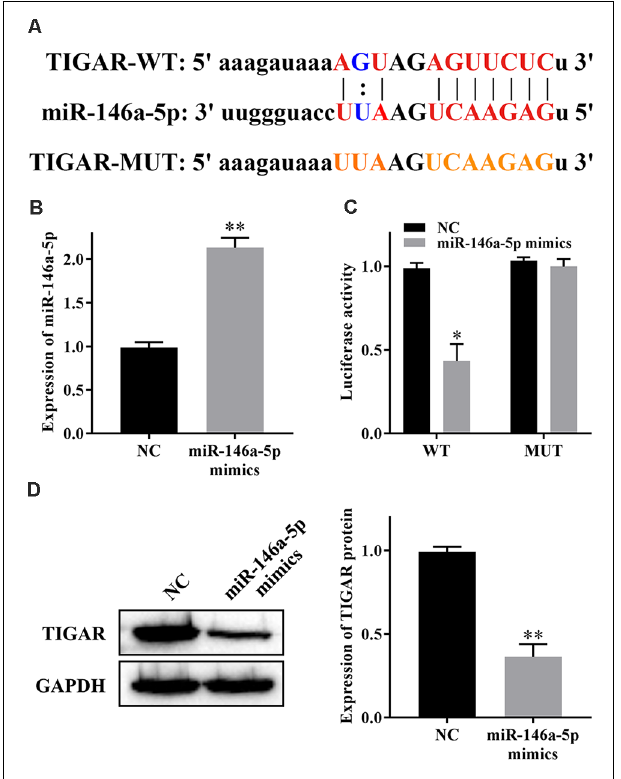
FIGURE 3 | miR-146a-5p reduces the expression of TIGAR. (A) Binding sites between miR-146a-5p and TIGAR. (B) Transfection efficiency of miR-146a-5p mimics. (C) Dual luciferase reporter gene assay. (D) Expression of TIGAR protein. ∗ P < 0.05 vs. NC group; ∗∗ P < 0.01 vs. NC group.